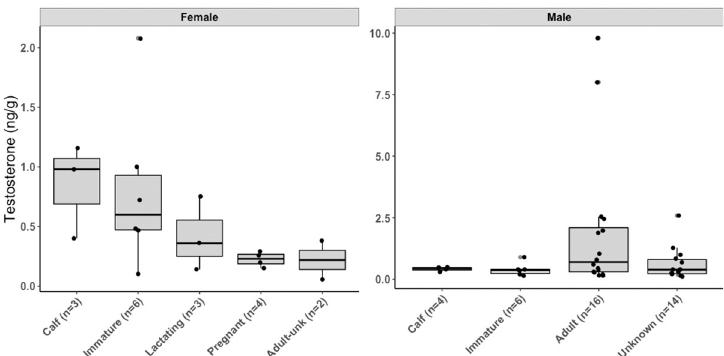
Fig 4. Testosterone concentrations (ng/g) in gray whale of different reproductive states (females) and age class (males). In females, testosterone concentrations were not statistically different among reproductive groups (ANOVA: F = 1.9, df = 4, P = 0.2). Boxplots denote median (thick line), upper (75%) and lower (25%) quartile (boxes) and largest and smallest value within 1.5 times interquartile range below 25% and above 75% (whiskers). Outside values are shown as filled circles.